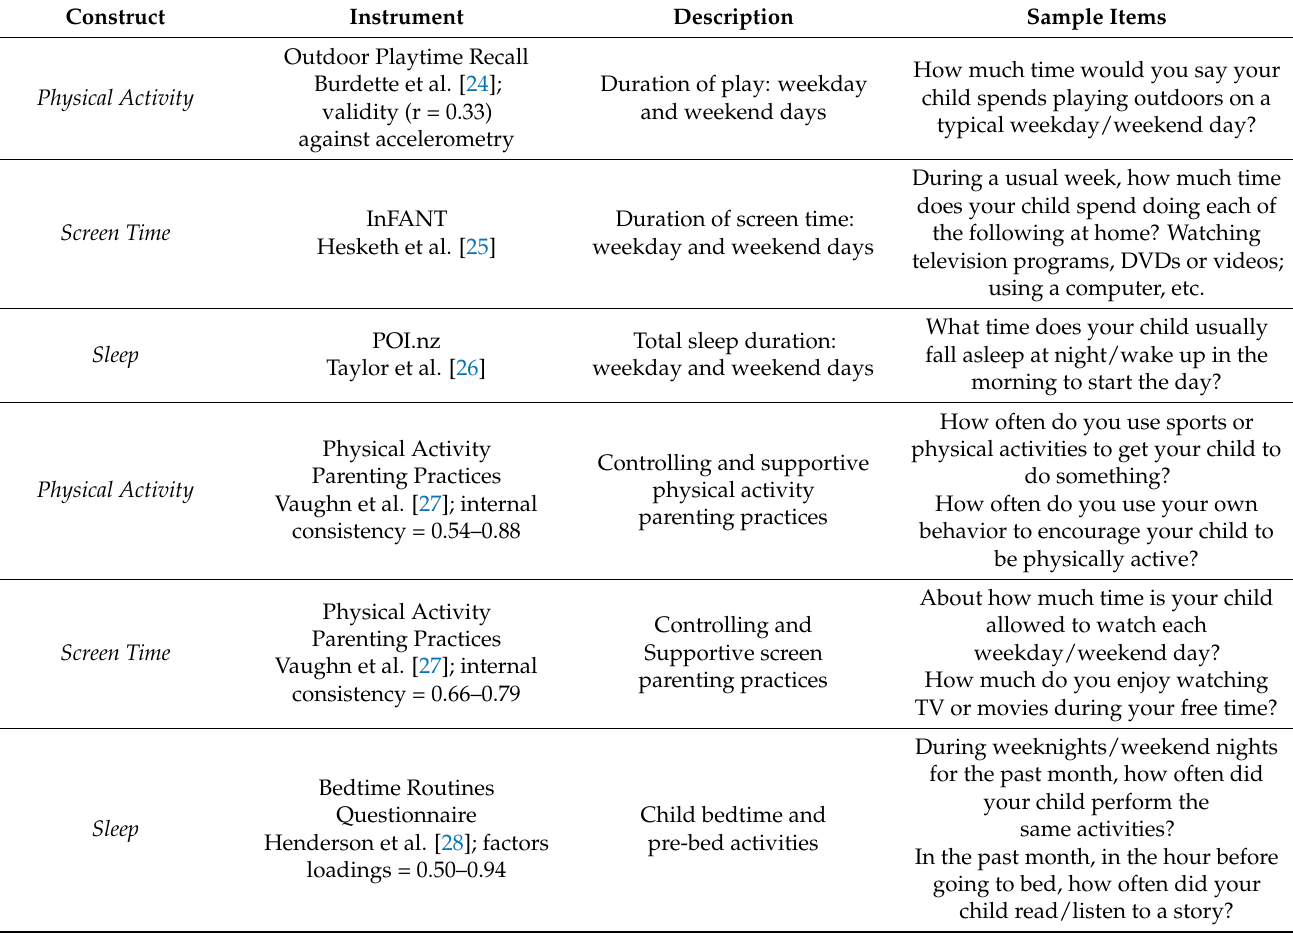
Table 1. Measurement scales selected for the cross-cultural translation